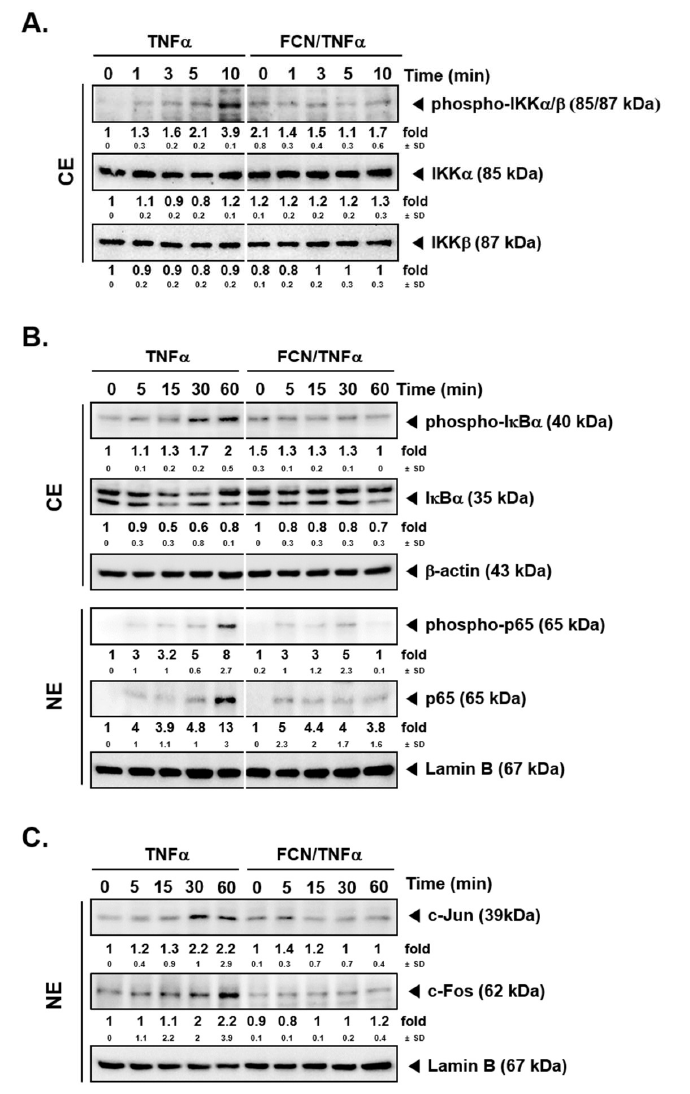
Figure 2. FCN affects NF-κB activation and IκBα degradation in KBM5 cells. KBM5 cells were pre- Figure 2. FCN a ff ects NF- κ B activation and I κ B α degradation in KBM5 cells. KBM5 cells treated with 15 μM of FCN for 2 h. After pre-treatment, 0.5 nM TNFα was added for the indicated